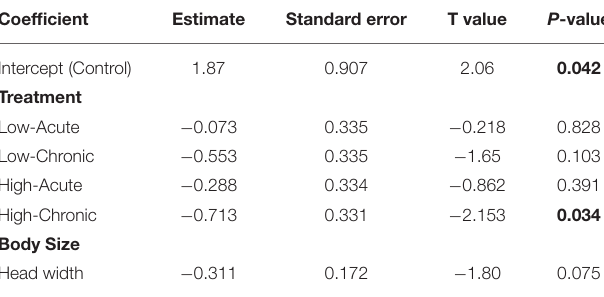
TABLE 1 | Results from a linear model testing for an association of deicing salt treatment (exposure and salt concentration) and body size on the melanization immune response in larval Anax junius